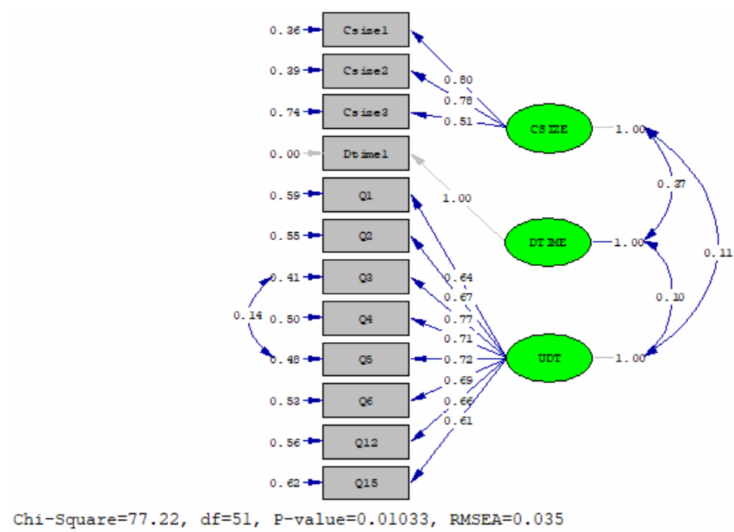
Figure 8. Relationships between